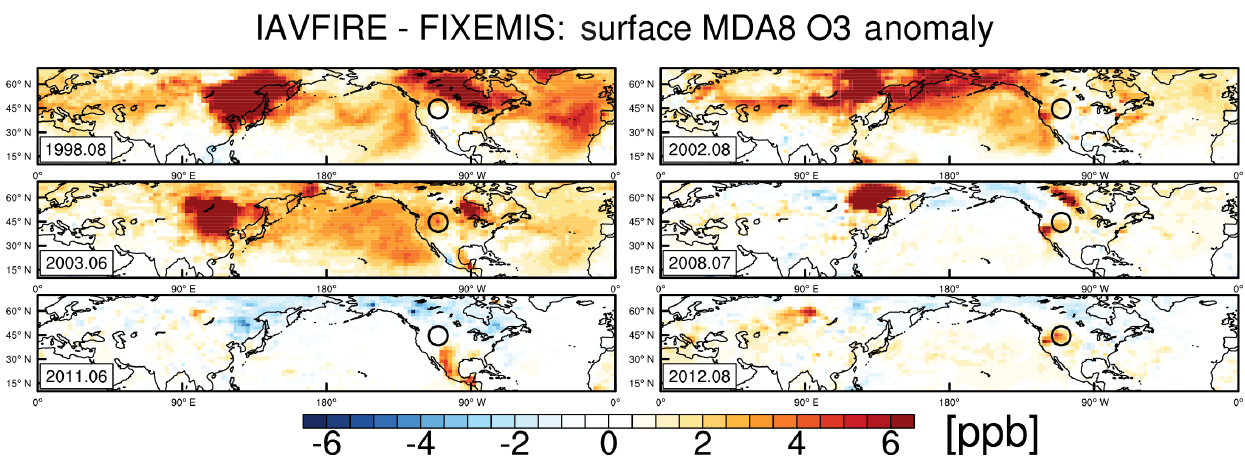
Figure 16. Surface MDA8 O 3 enhancements from wildfire emissions for individual months in the years with large biomass burning in boreal regions (1998, 2002, 2003) and over the WUS (2008, 2011, 2012), as diagnosed by the differences between IAVFIRE and FIXEMIS. The black circle denotes the location of Yellowstone National